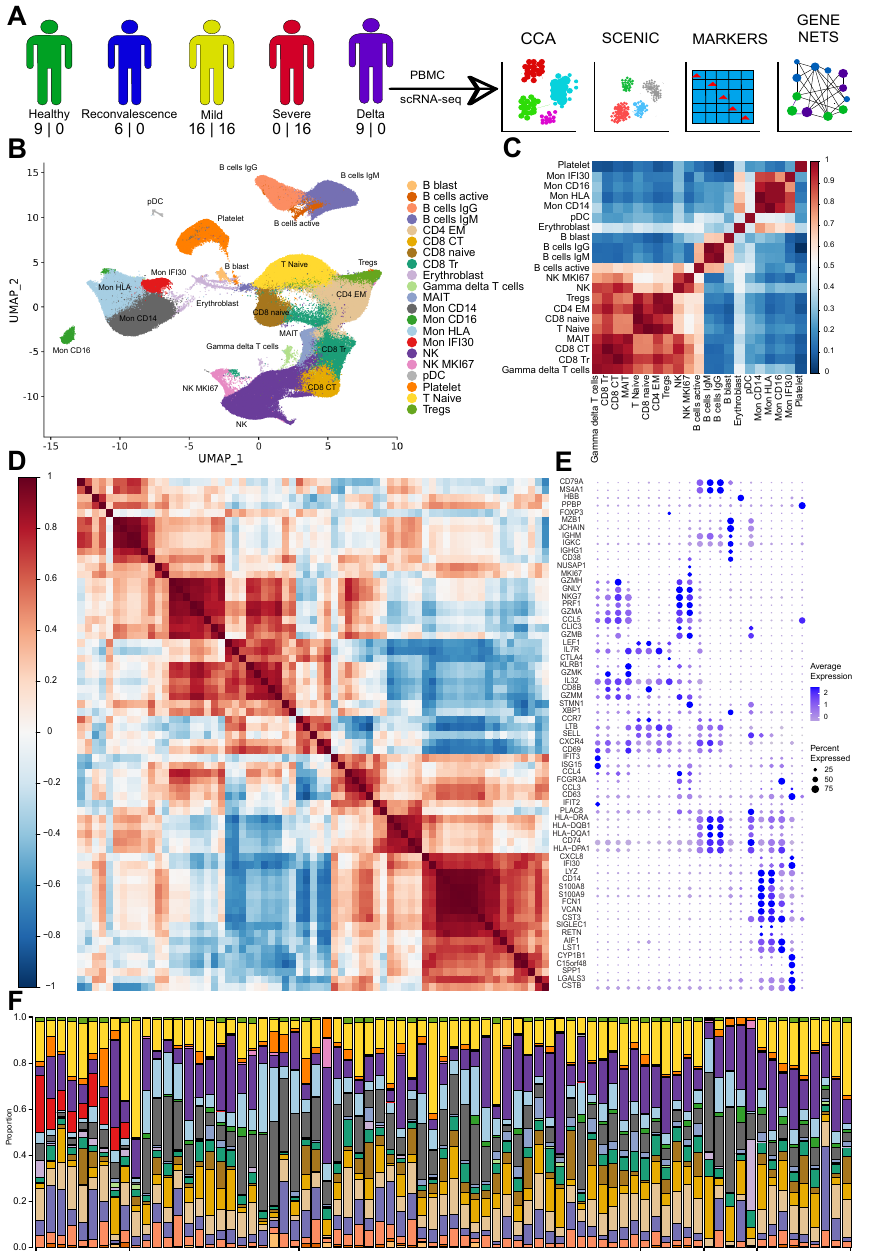
Figure 1. ( A ) Schematic diagram showing assays performed on the PBMC of COVID − 19 patients with numbers of newly sequenced and publicly available samples (shown as number in correspond- ing order). The diagram shows performed computational analysis regarding computational data integration made with Seurat CCA and SCENIC, identification of marker genes, and computational reconstruction of the Gene Regulatory Network. ( B ) UMAP with identified cell types. ( C ) Cell − cell correlation heatmap based on Pearson correlation of the average expression of highly variable genes depicting across cell types similarity. ( D ) Gene expression Pearson correlation heatmap indicating formed gene modules by marker genes. ( E ) Dot plot with the expression of marker genes for each cell type ordered according to the correlation on the ( C ), and gene ordered based on ( D ). Three plots ( C – E ) allow joint view highlighting similarity based on activity level of marker genes and cell type closeness as follows from the average expression correlation of highly variable genes. ( F ) Stacked bar plot with cell type fractions for each sample colored according to the pallet of UMAP. We identified clearly visible Mon IFI30 cells fraction in the samples with Delta